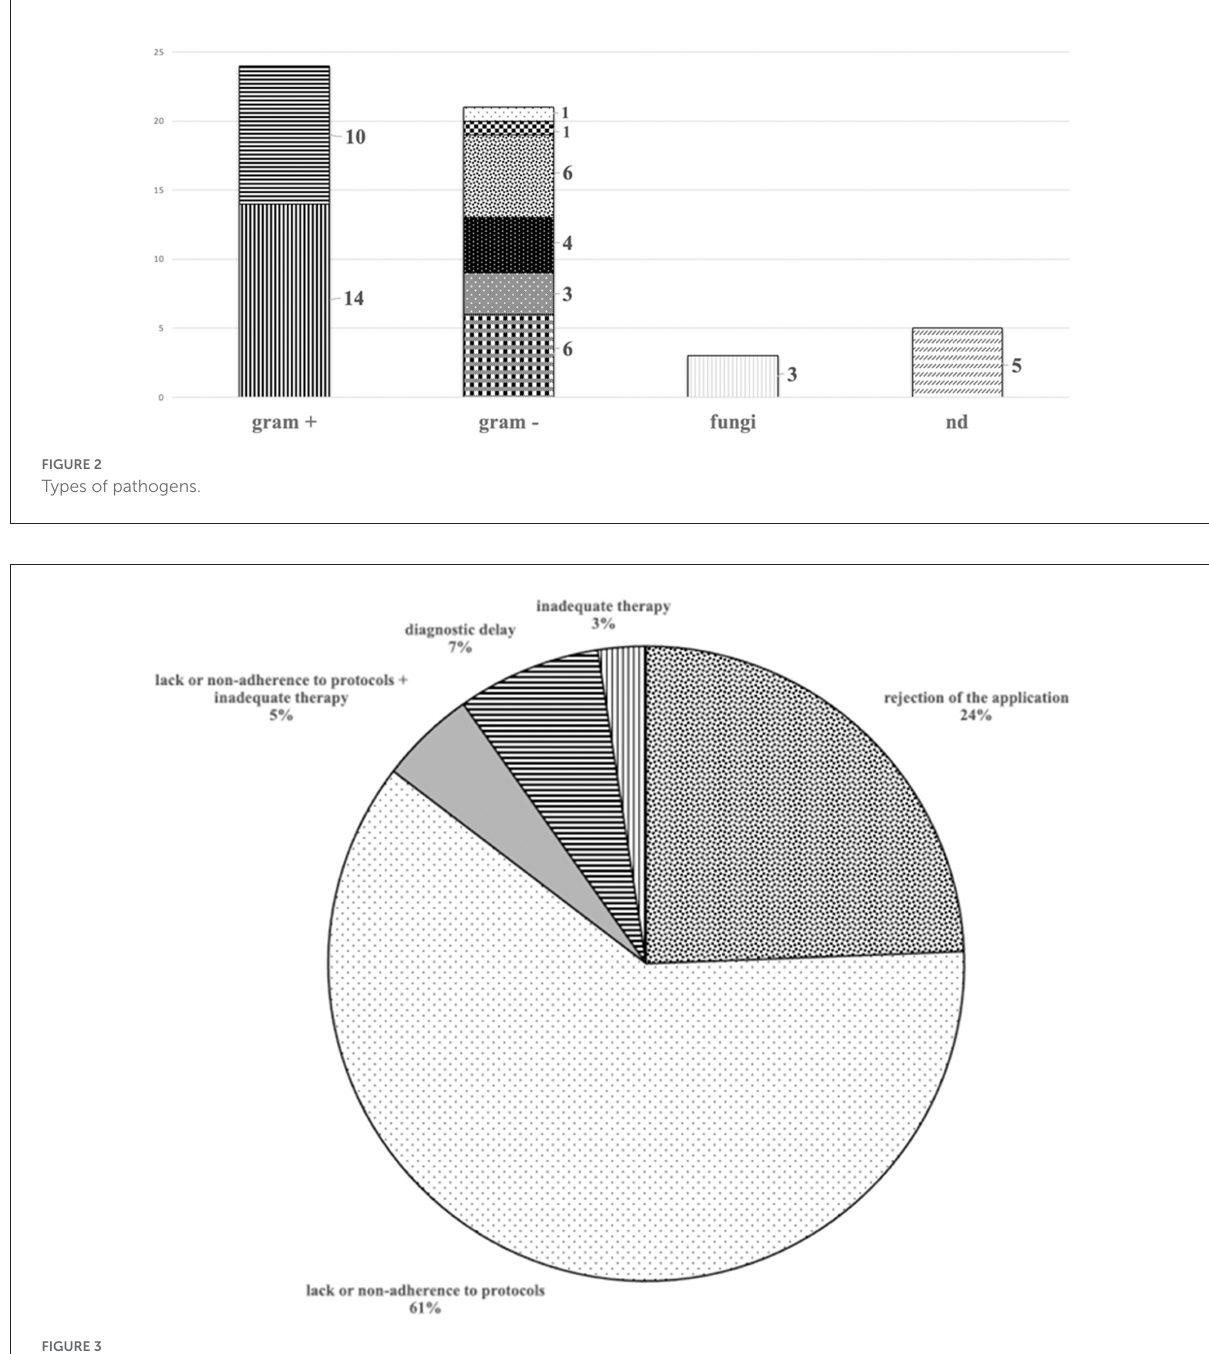
FIGURE3 Reasons of acceptance or rejection of the requests of compensations.